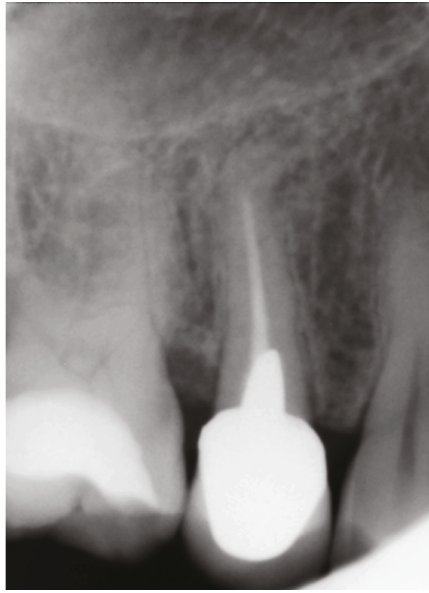
Figure 3: Periapical radiograph showing immediate outcome of nonsurgical endodontic retreatment performed at our dental o ffi